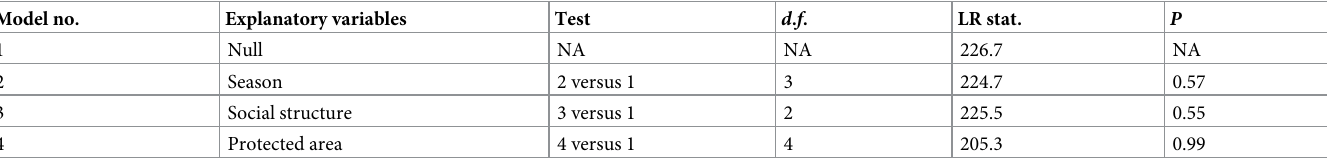
Table 2. Results of sequential likelihood ratio tests of multinomial models with random intercept testing the effect of season, social structure, and protected area on prey choice. LR stat. = likelihood ratio statistic (difference of residual deviance); NA = Not Applicable. Model no. Explanatory variables Test d . f . LR